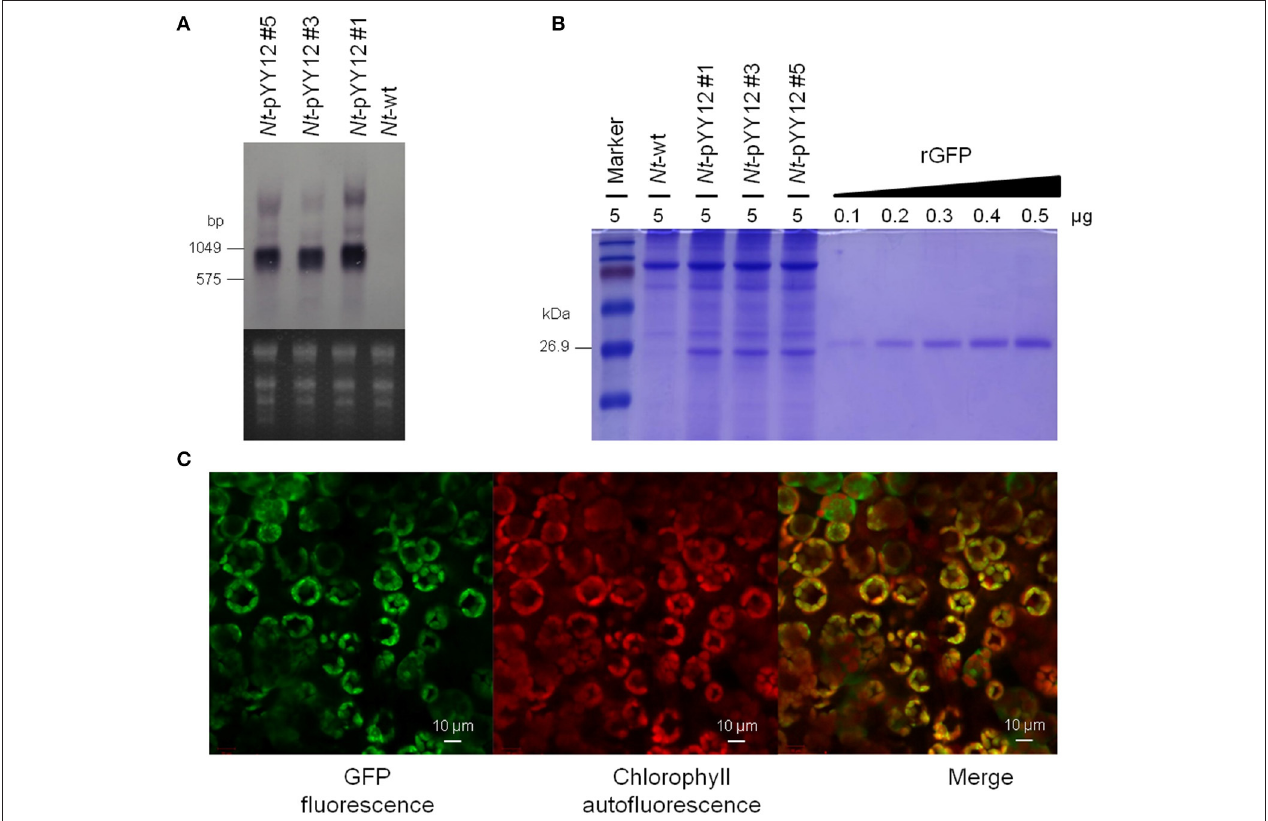
FIGURE 4 | Analysis of GFP expression in transplastomic tobacco lines. (A) Northern blot analysis of gfp mRNA accumulation in leaves of transplastomic tobacco plants. The ethidium bromide-stained gel prior to blotting is shown below the blot. (B) GFP accumulation in leaves. Protein samples were separated by 18% SDS-PAGE and the gel was subsequently stained by Coomassie Brilliant Blue R-250. The amount of total protein loaded in each lane is indicated ( µ g). For semi-quantitative analysis, a dilution series of recombinant GFP was loaded. Note the larger size of the rGFP due to its hexahistidine tag. (C) Subcellular localization of GFP in transplastomic plants. The images correspond to subepidermal cells of 8-week-old seedlings. From left to right: GFP fluorescence (green), chlorophyll autofluorescence (red), and merged